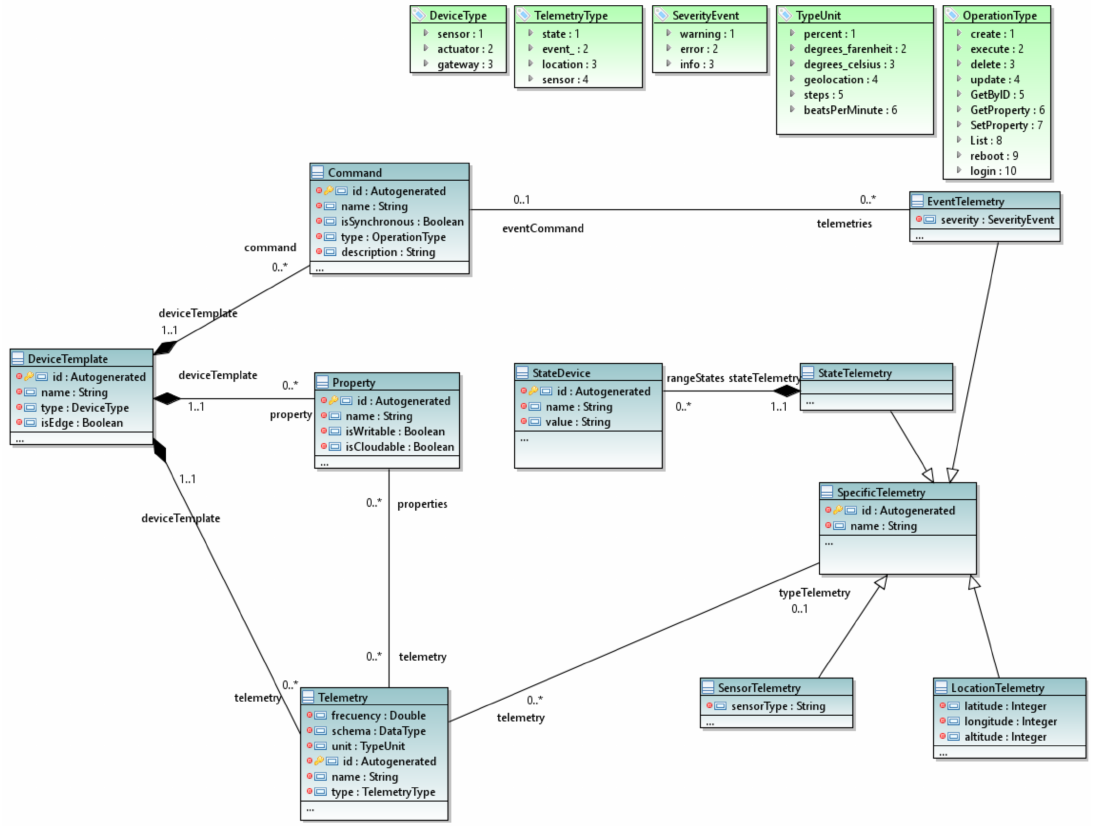
Figure 4. The device